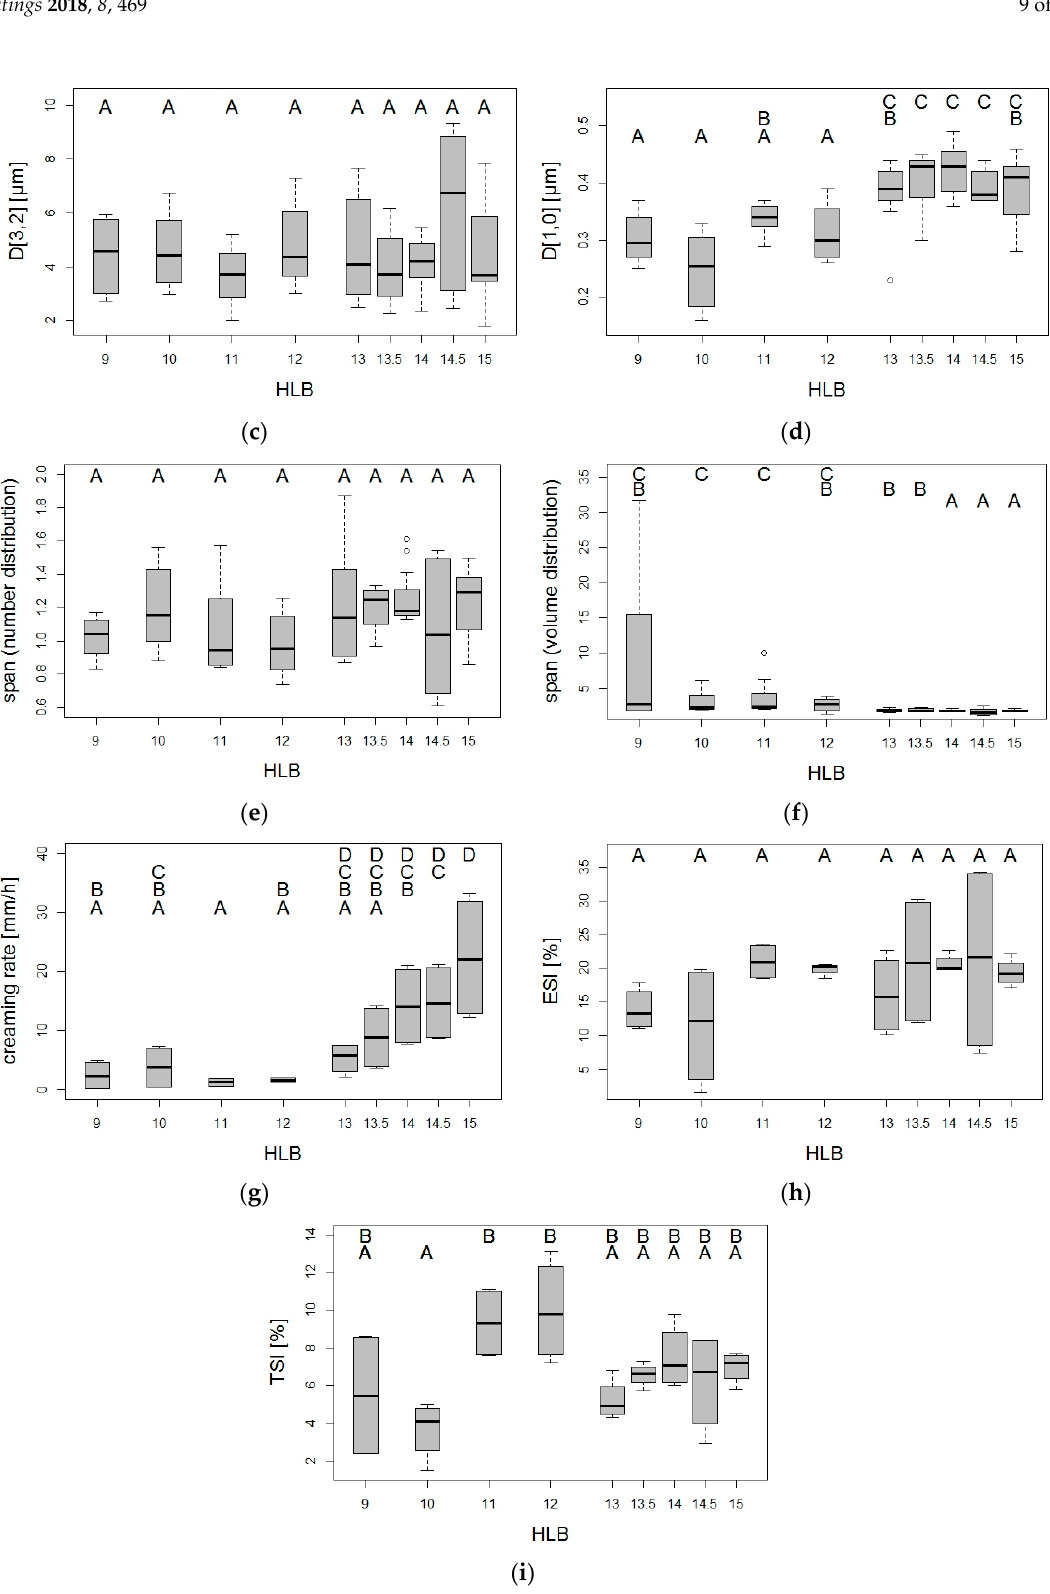
Figure 4. Effect of the surfactant blend on the ( a ) dynamic viscosity of the continuous phase, ( b ) volume-weighted moment mean diameter d 4,3 , ( c ) surface area mean diameter d 3,2 , ( d ) number mean diameter d 1,0 , ( e ) span of the number distribution, ( f ) span of the volume distribution, ( g ) flotation rate of the wax particles, ( h ) emulsion stability index (ESI), and ( i ) Turbiscan stability index (TSI). Note: Letters above represent post hoc test results, and different letters represent different statistical groups (Tukey honestly significant difference (HSD) or Dunn’s test, p < 0.05).